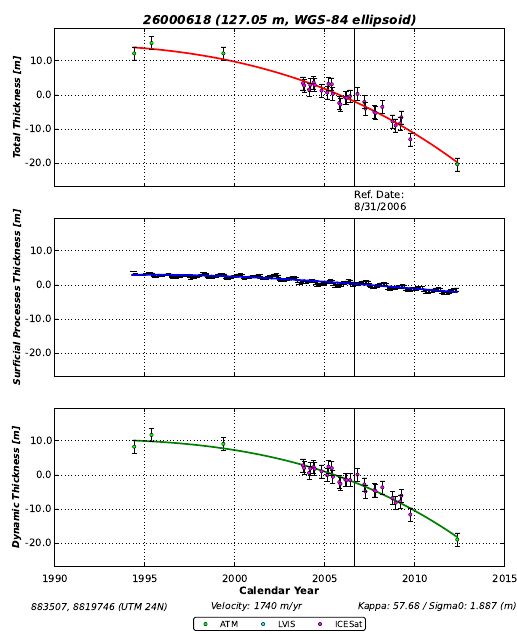
Figure 3. Time series of total ice thickness (upper panel), ice thickness changes due to surficial processes (middle panel) and caused by ice dynamics (lower panel) near the grounding line of Zachariæ